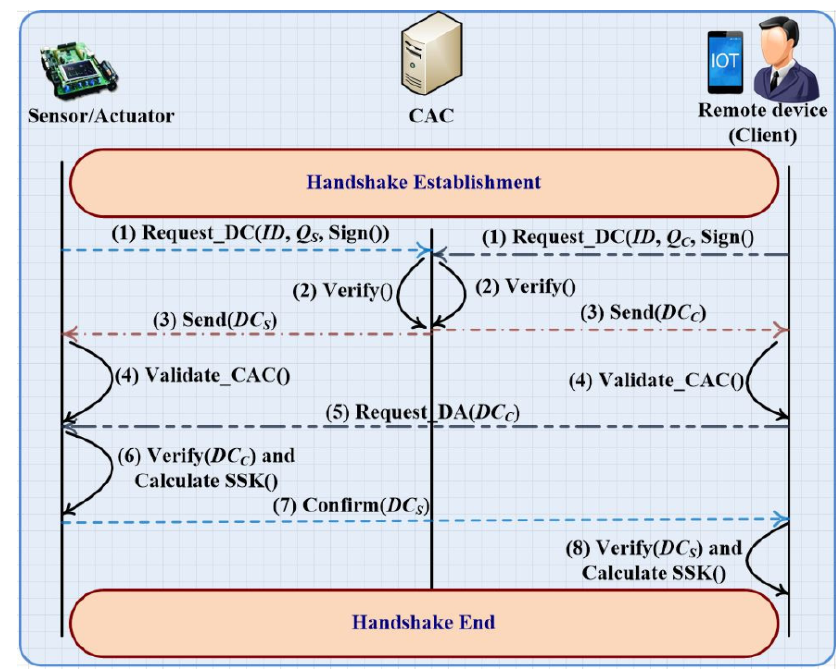
Figure 1. Issuance of digital certificate and handshake establishment algorithm.